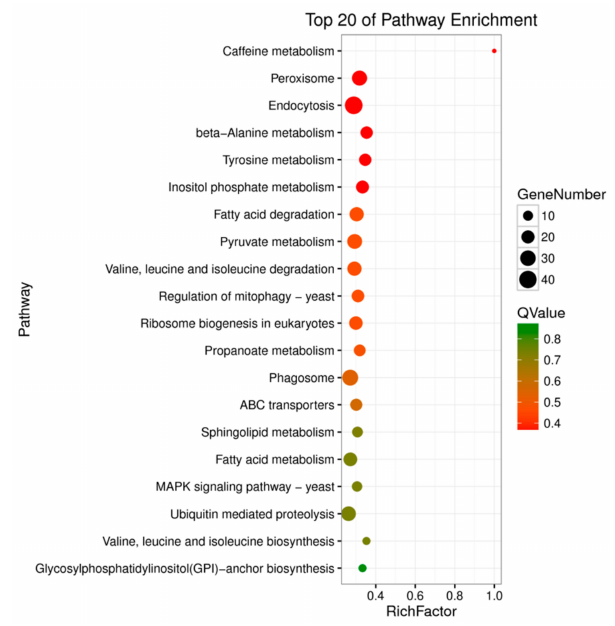
Figure 7. KEGG pathway enrichment analysis for DEGs of P. capsici